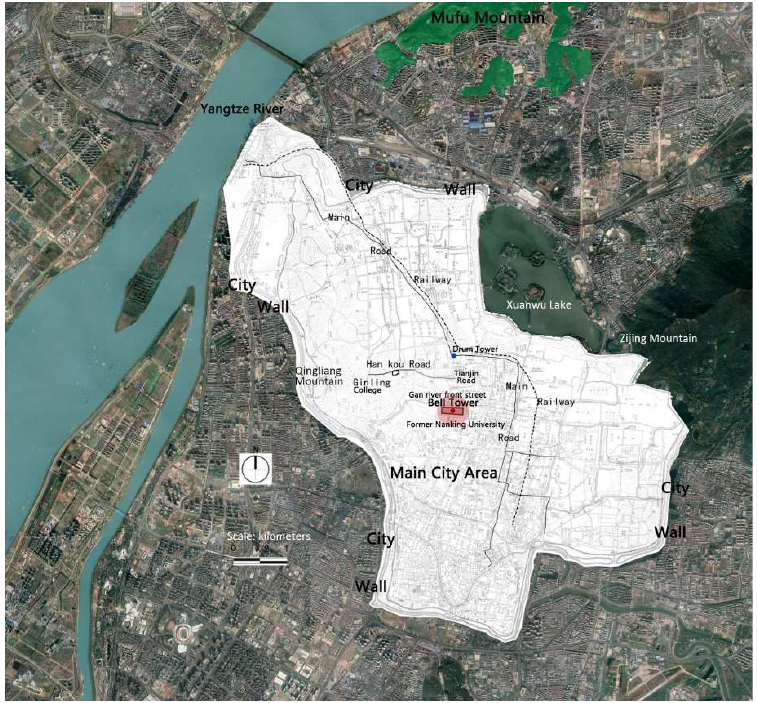
Figure 2. Location of the bell tower in Nanjing (based on Google Earth, 2022).